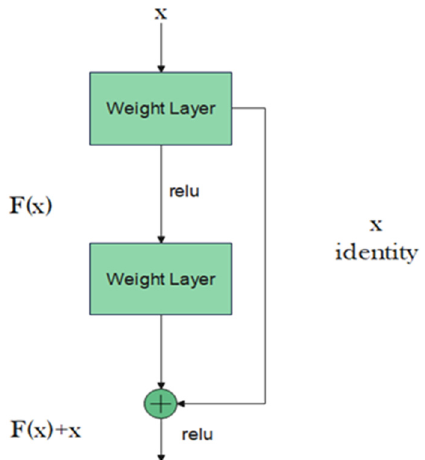
Figure 2. Residual block.